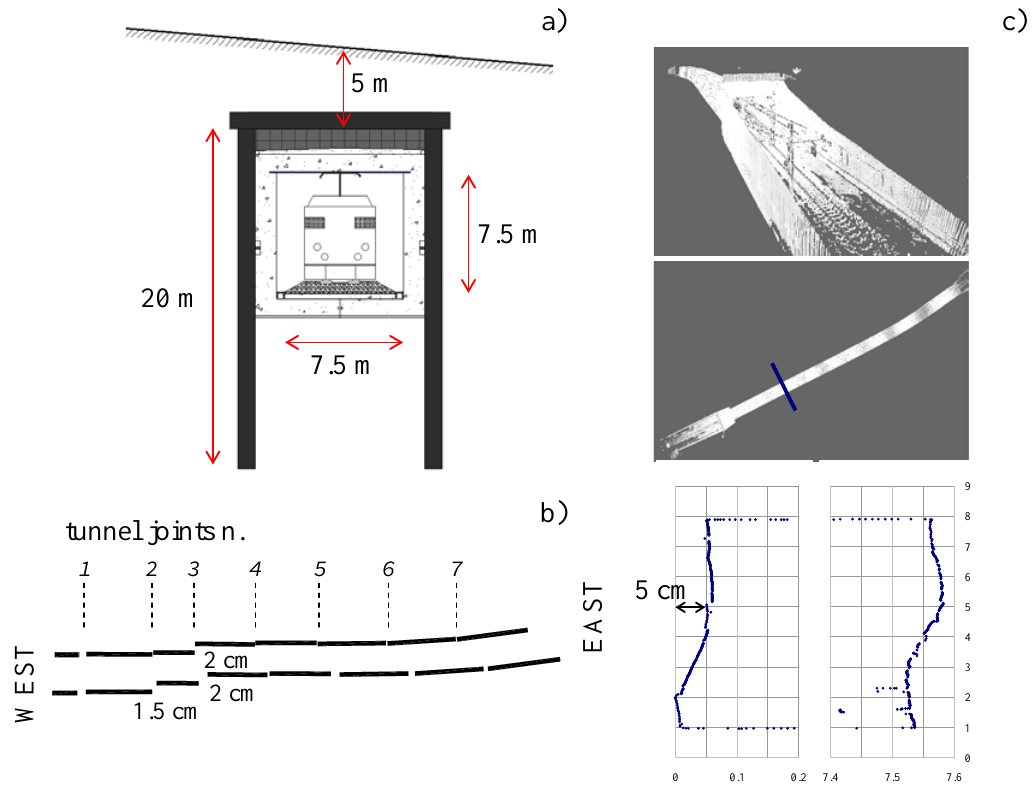
Figure 4. Cross-section at the middle of the tunnel ( a ); tunnel sectors with an indication of the concentrated sectors’ misalignment at the joints ( b ); tunnel geometry by 3D laser scanning ( c ).